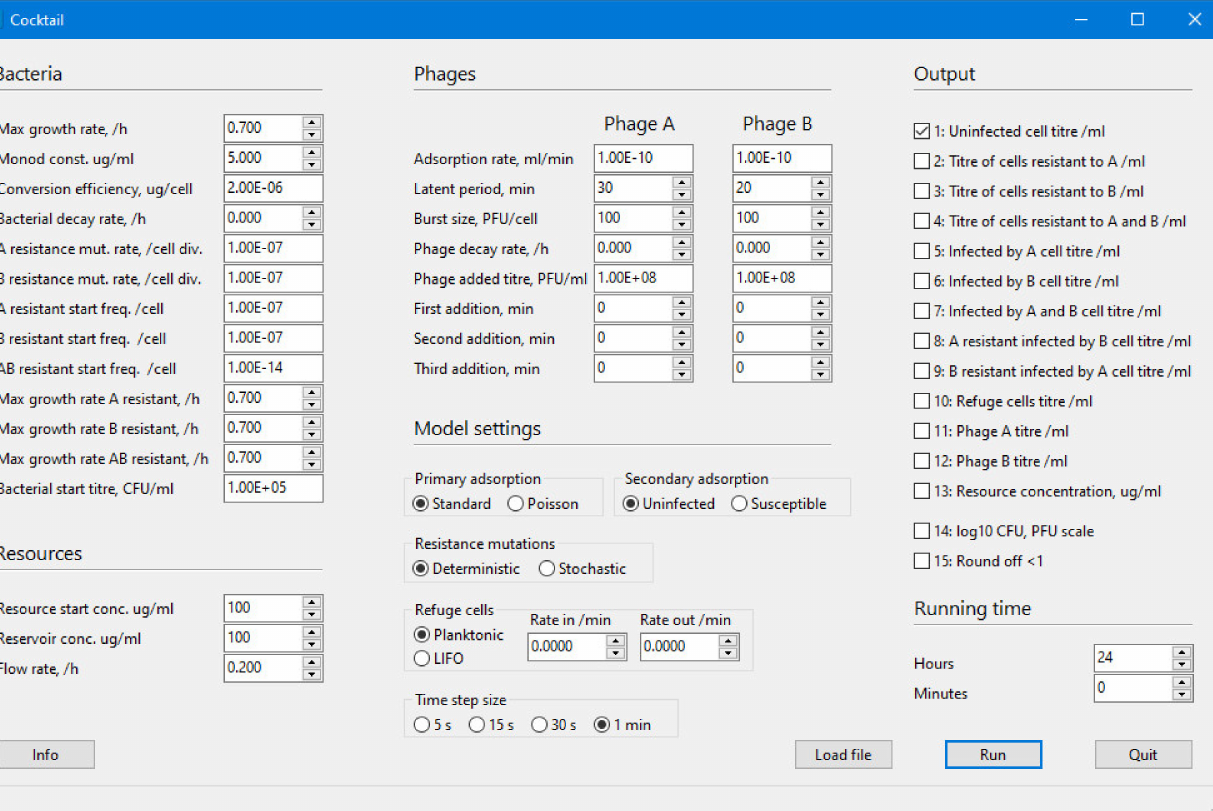
Figure 1. The Cocktail user